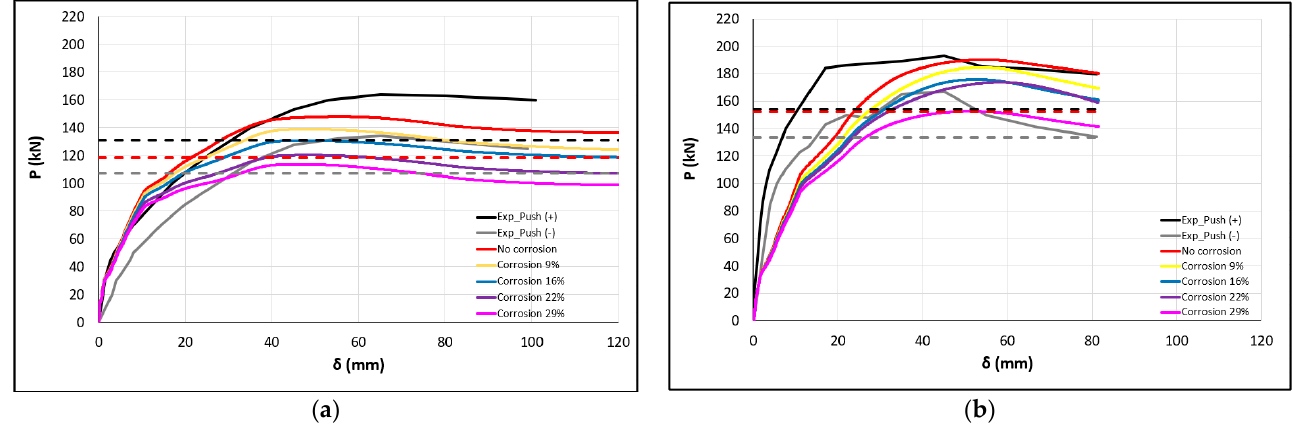
Figure 14. Analytical base shear force–displacement curve for ( a ) A1F and ( b ) B2 with different corrosion levels, compared against the experimental ones.